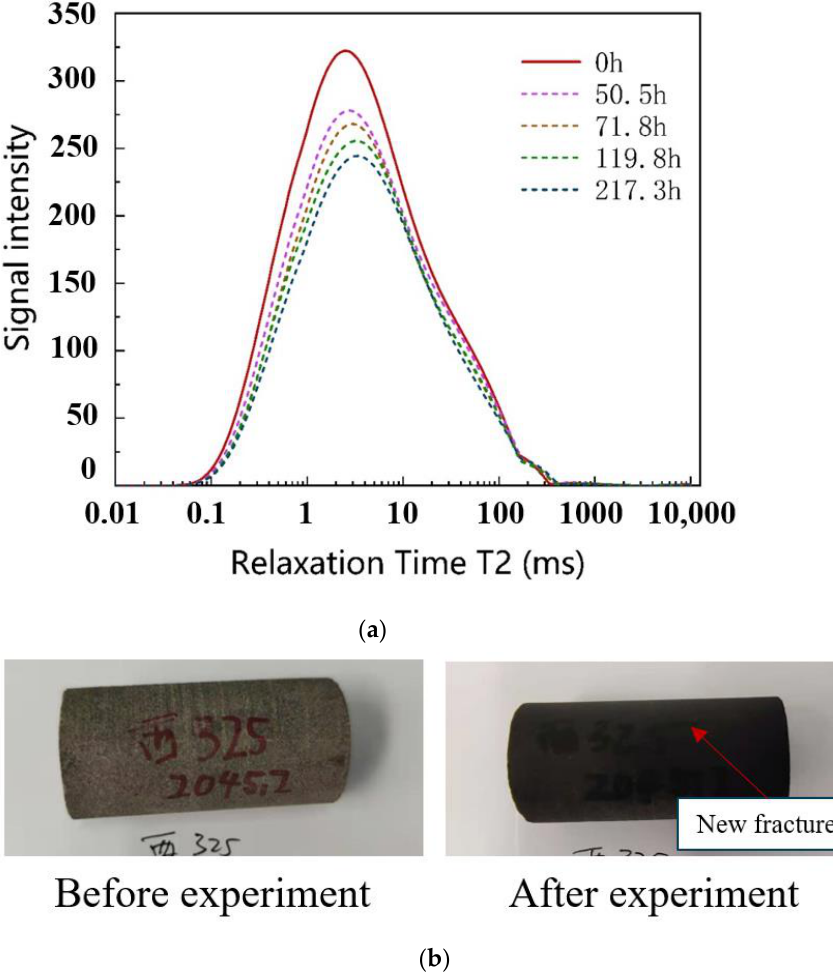
Figure 10. Development of T 2 of sample XEW under 10 MPa. ( a ) The development of T2 with time; ( b ) The new fracture on the surface of the sample after the experiments.